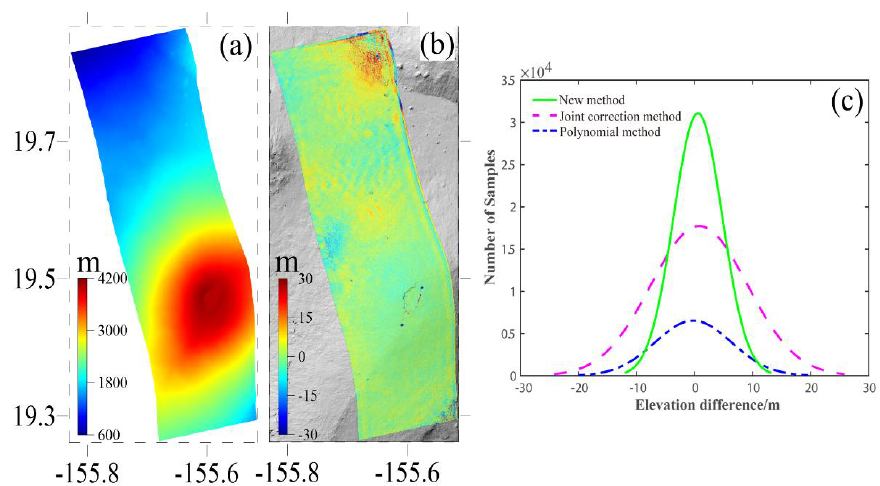
Figure 6. ( a ) The InSAR DEM generated from the corrected HH-polarization interferograms by the proposed method. ( b ) The elevation difference between InSAR DEM obtained by the proposed method and TanDEM-X DEM. ( c ) Histograms of the elevation difference between the InSAR-derived DEMs and the TanDEM-X DEM.